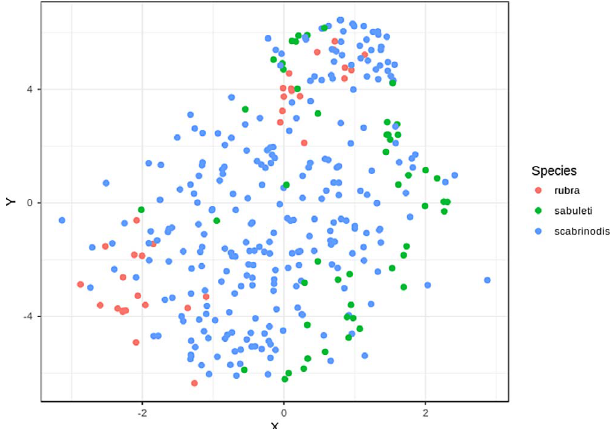
Figure 5. Visualisation of infection patterns based on absolute thallus number on 16 body parts, using t-SNE to reduce the number of dimensions of the data set ( n =